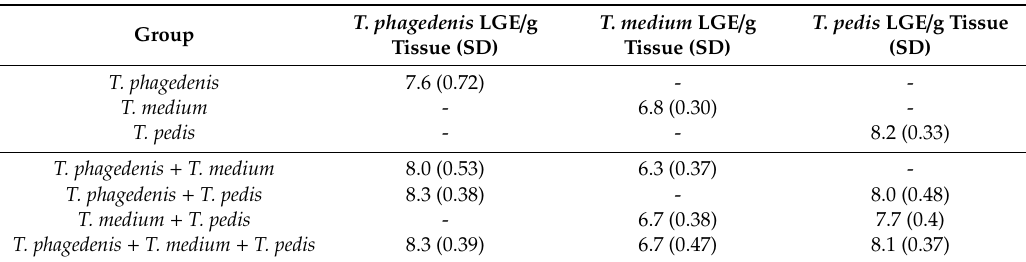
Figure 3. Quantities of Treponema spp. in the abscesses of mice subcutaneously inoculated expressed as log10 of Treponema genomic equivalents (GE) per gram of tissue. ( A ) Mice infected with single Treponema spp.; and ( B ) mice infected with Treponema spp. combinations. Bars represent the mean and error bars indicate standard deviation. *** p < 0.001. Table 2. Mean (SD) Treponema spp. quantities detected by qPCR in the abscesses of inoculated mice. Quantities expressed as logarithmic genomic equivalents (LGE) per gram of tissue.